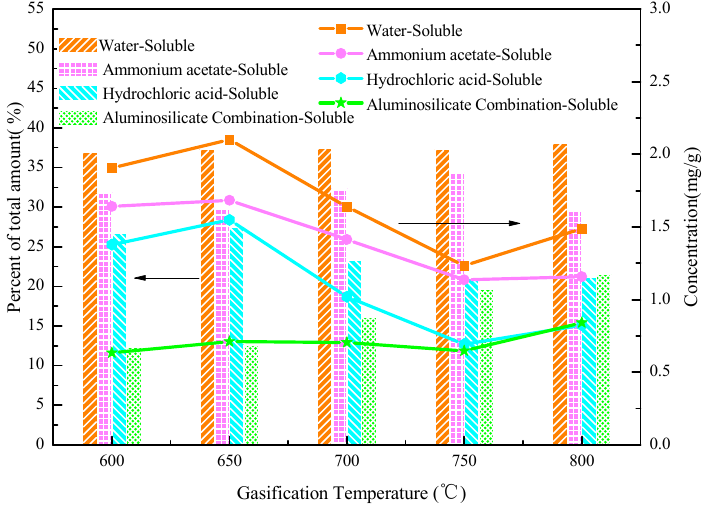
Figure 4. Variation of occurrence mode of Na with gasification temperature.